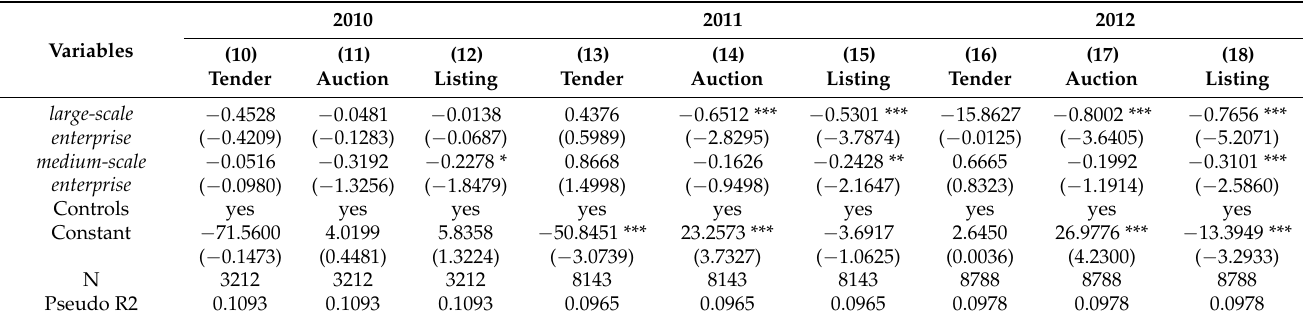
Table A6. Results of mlogit model considering scale of enterprises (2010–2012).